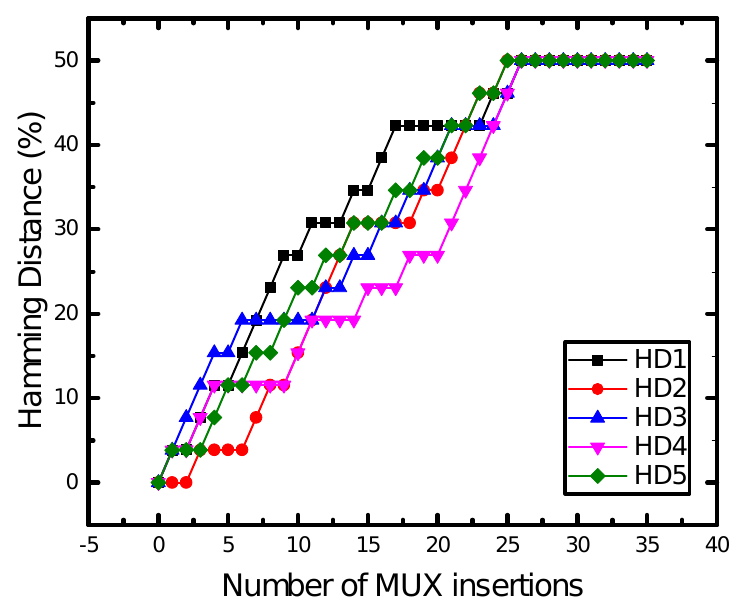
Figure 7. The Hamming distance when five different random keys were supplied for C880.